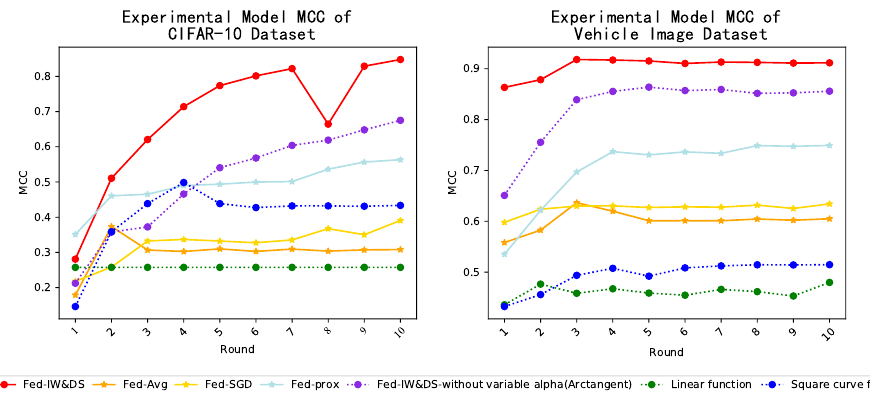
Figure 7. Comparison of